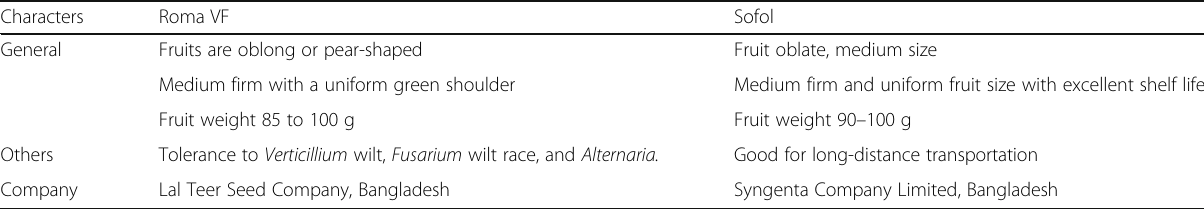
Table 1 Basic information about two tomato varieties in Bangladesh Characters